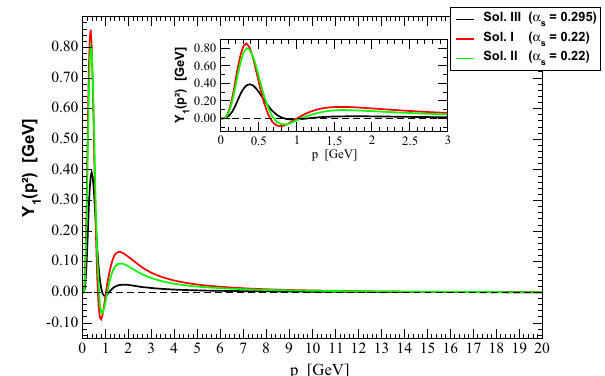
Fig. 34 The quark-ghost kernel form factor X 1 ( p 2 ) computed using α (μ) = 0 . 22 s